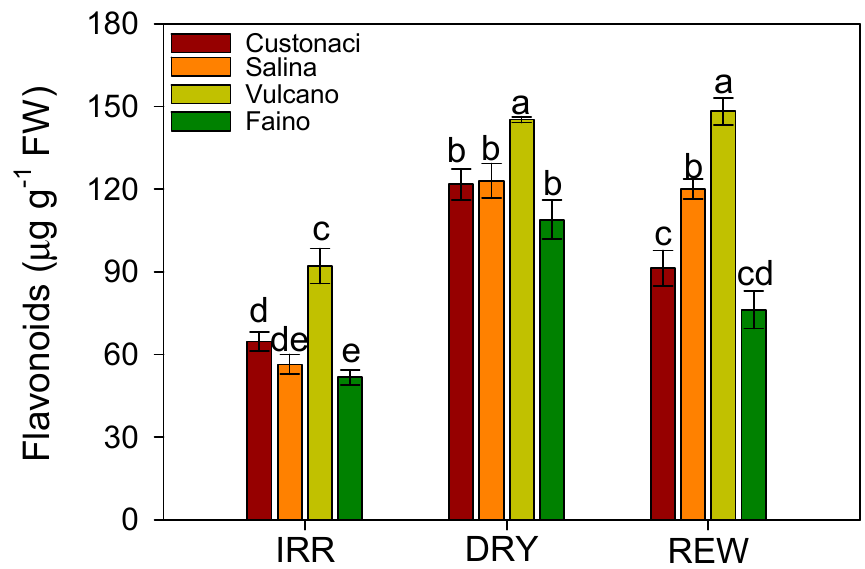
Figure 4. Flavonoids content in fruits of four cultivars of tomato in response to irrigation (IRR: full irrigation; DRY: no irrigation; REW: rewatering). Bars are mean value ± standard error ( n = 3). Different letters among cultivars across irrigation treatments indicate significance at p ≤ 0.05 by Tukey’s test.